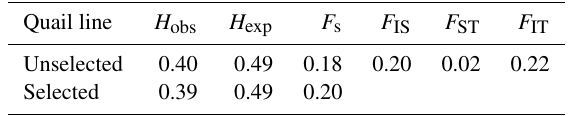
Table 4. Genetic diversity within quail populations. Quail